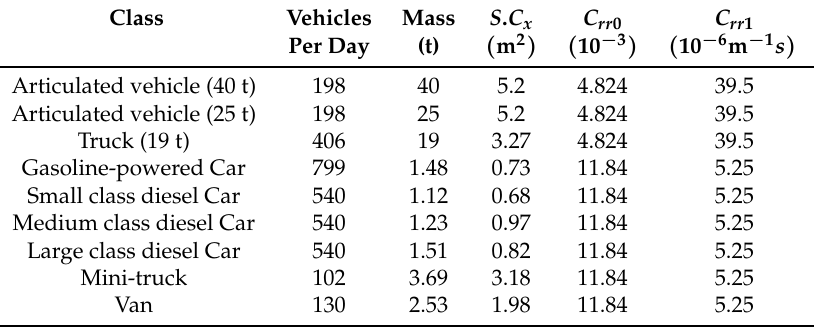
Table 3. Vehicle data (t: metric ton) adapted from